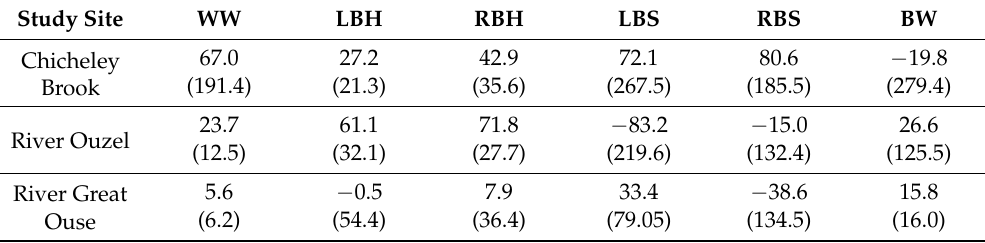
Table 9. Average discrepancy (in percentage) of the Structure from Motion (SfM) derived hydromorphological measures with respect to the Total Laser Scanner (TLS) derived measures at cross-section level for the 40 m long reaches at the Chicheley Brook, River Ouzel and River Great Ouse sites. The measures reported refer to: wetted water width (WW), left bank height (LBH), right bank height (RBH), left bank slope (LBS), right bank slope (RBS) and bank width (BW). Values in brackets represent the standard